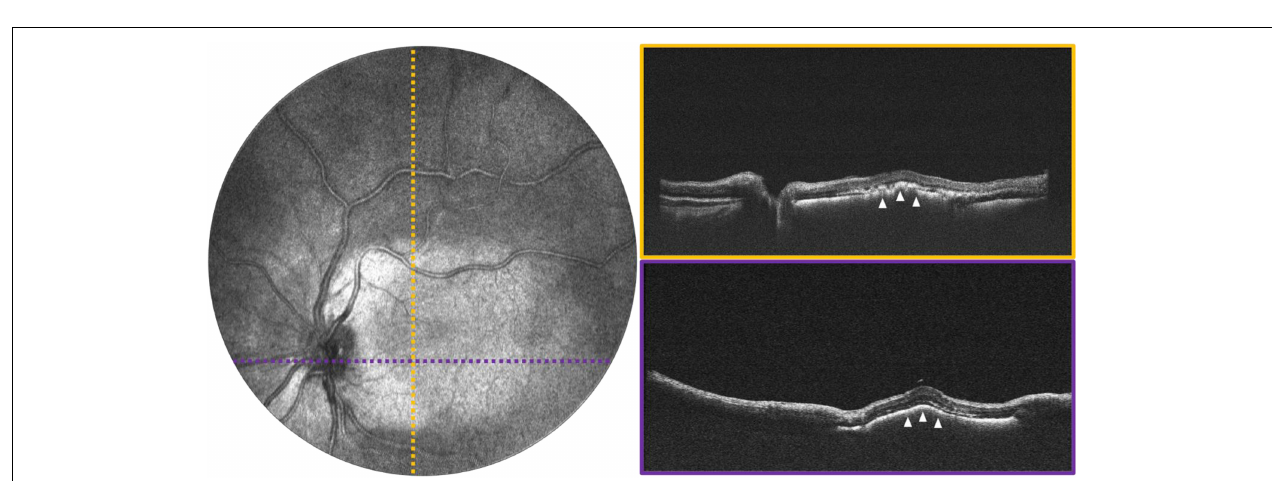
FIGURE 5 | Macular exudation in a 2-year-old with Coats disease. (Left) Image shows 55 ◦ FOV OCT en face projection, with dotted lines indicating the locations of the color-coded B-scans shown on the (right) . White arrows point to the area of subretinal exudation.